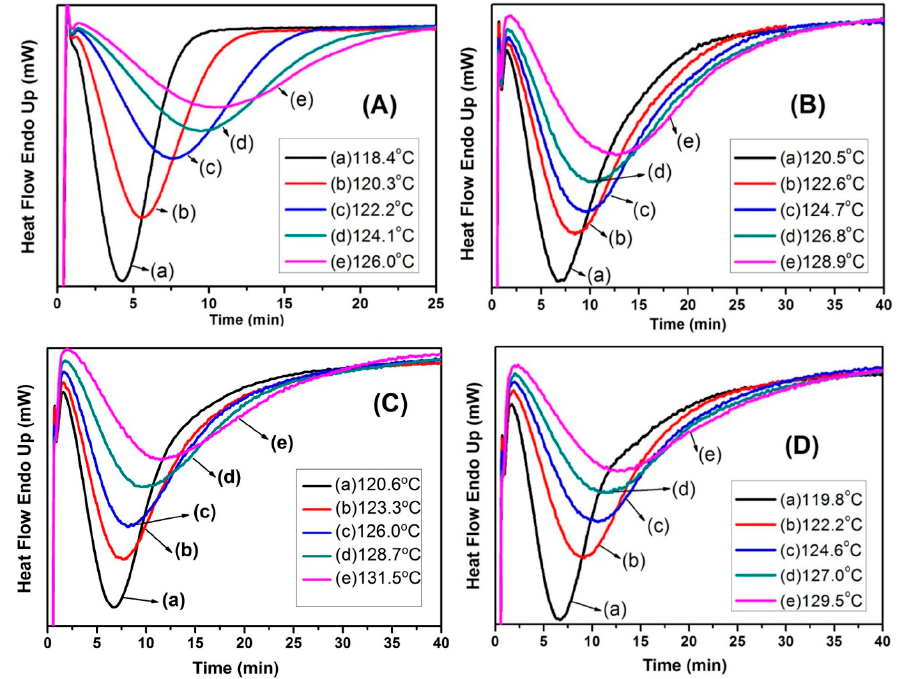
Figure 8. The DSC diagram of the PLLA-PEG200 copolymer, adding different amounts of o-MMT. The crystallization curves were under isothermal crystallization. The amount of o-MMT was ( A ) 0%, ( B ) 0.5%, ( C ) 1.0%, and ( D ) 1.5%, respectively. Table 3. The t 1/2 , ∆ H c , and crystallization time list of PLLA-PEG200 copolymer and PLLA-PEG200/o- MMT nanocomposites under isothermal crystallization.